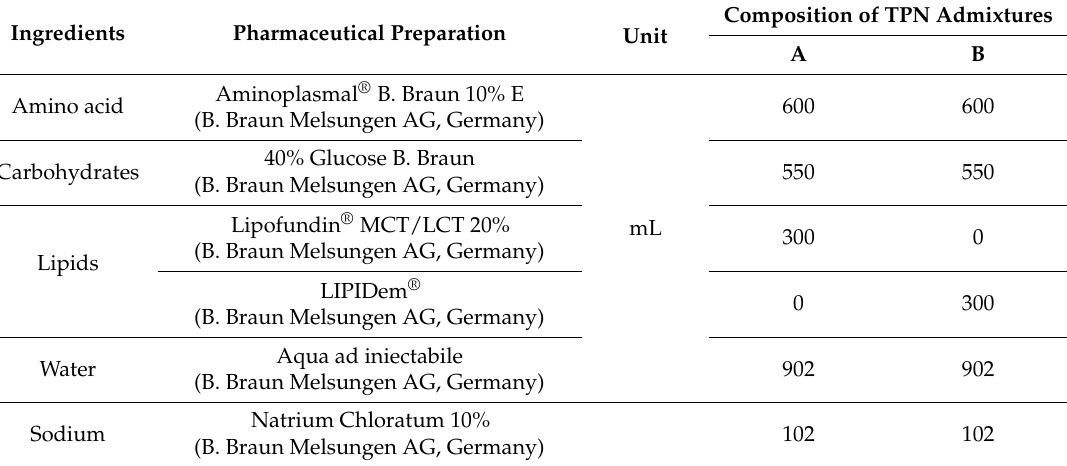
Table 1. Composition of TPN